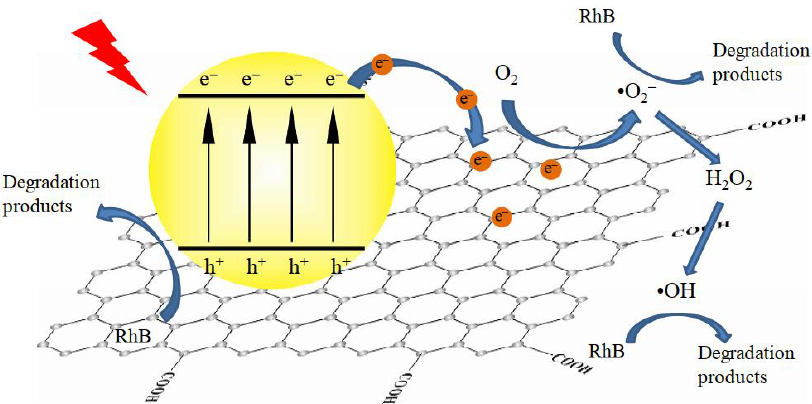
Figure 14. Photocatalytic mechanism of g-C 3 N 4 /rGO (reduced graphene oxide) for the degradation of Rhodamine B. Reprinted with permission from Ref. [122]. Copyright 2015 Elsevier. Table 3. Photocatalytic degradation of pollutants over g-C 3 N 4 -based materials reported within the last three years.